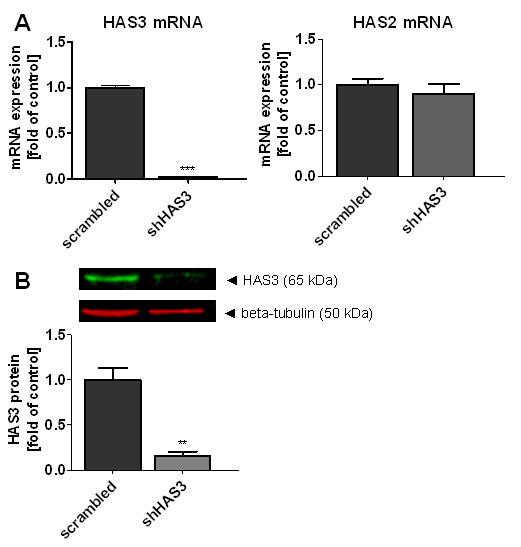
Lentiviral knockdown of HAS3 in OSC1 cells. The transduction with lentiviral shHAS3 results in (A) a strong decrease of HAS3 mRNA without affecting HAS2 mRNA levels. (B) A significant reduction of HAS3 protein levels was found. Shown are the results of three independent RT-PCR experiments and a representative immunoblot of HAS3 with quantitative analysis of n = 3 experiments, mean ± SEM, ** p < 0.01, *** p < 0.001.